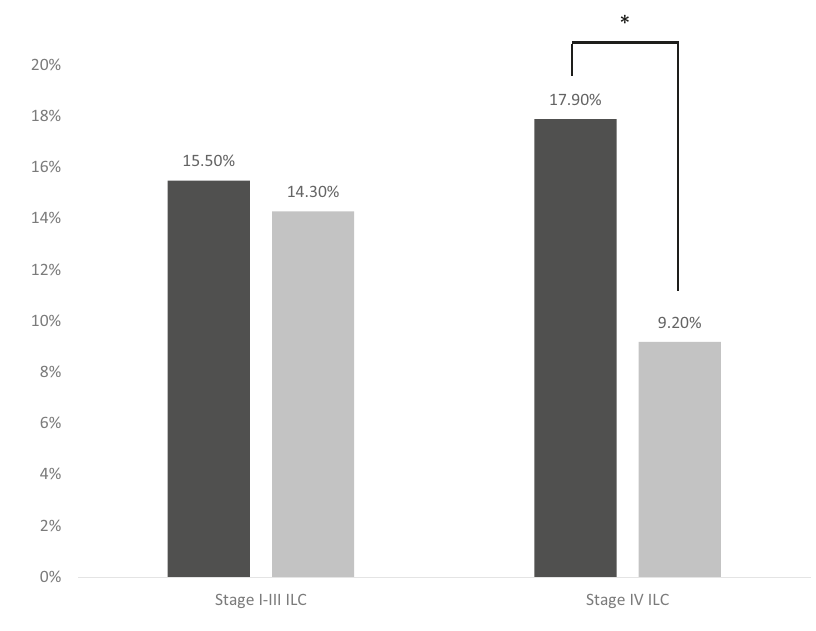
Fig. 1 Proportion of patients with invasive lobular carcinoma in the UCSF Cancer Registry versus the OnCore Clinical Trials Management System (CTMS), strati fi ed by stage. Patients with stage IV invasive lobular carcinoma (ILC) are signi fi cantly under-represented in the OnCore CTMS registry compared with the UCSF Cancer Registry. *Two-sample test of proportion: p =